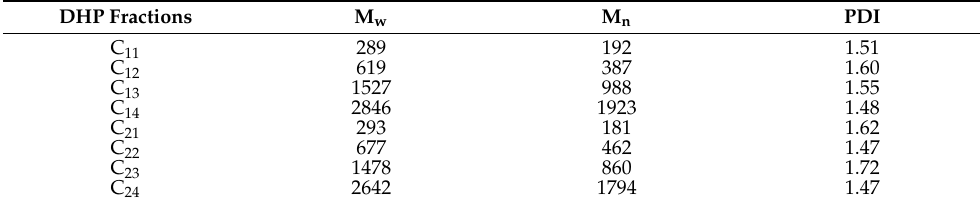
Table 1. Average molecular weight of DHP fractions.